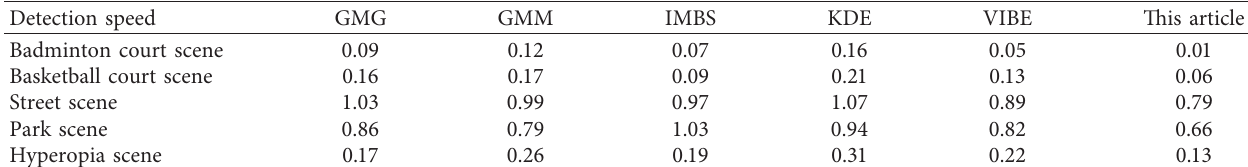
Table 7: Data of speed indicators for scene detection of dynamic background video library.